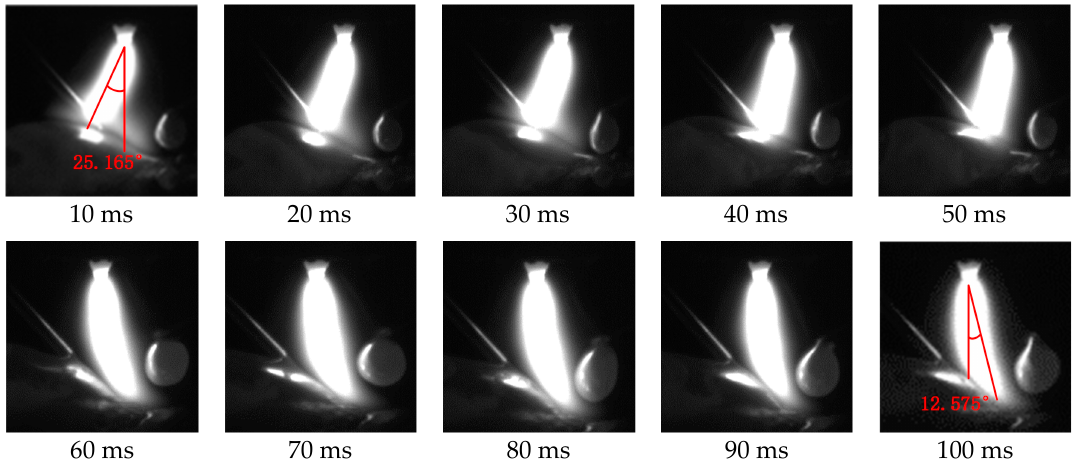
Figure 5. Arc swing in the model of “bridge transfer + free transfer.”